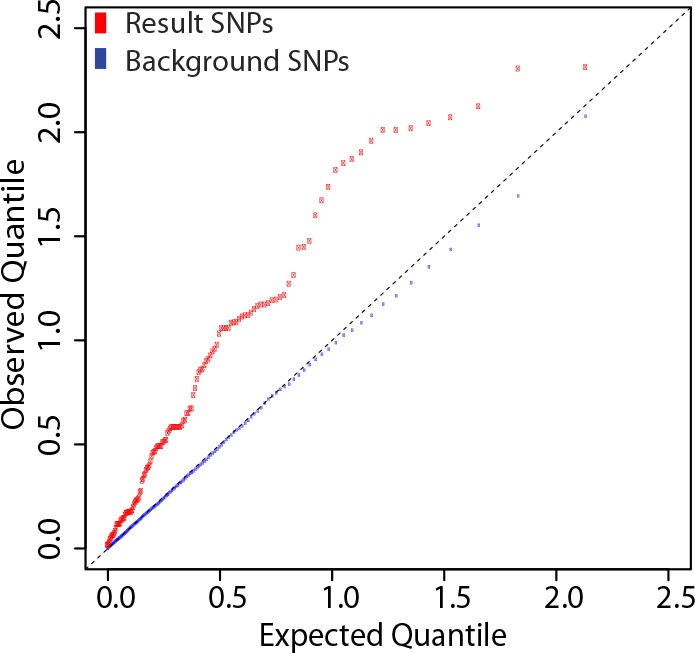
SNPs at the 20 loci identified show evidence of association with the antibody response to the vaccine.137 SNP-transcript pairs with evidence of a strong cis-eQTL, a dynamic response to the vaccine (a change in transcript abundance or in the magnitude of the genetic effect), and correlation between the transcriptional and antibody responses were selected (result SNPs, in red). The empirical quantile-quantile plot of the result SNPs shows significant deviation from the empirical distribution of the entire data set (background SNPs, in blue).